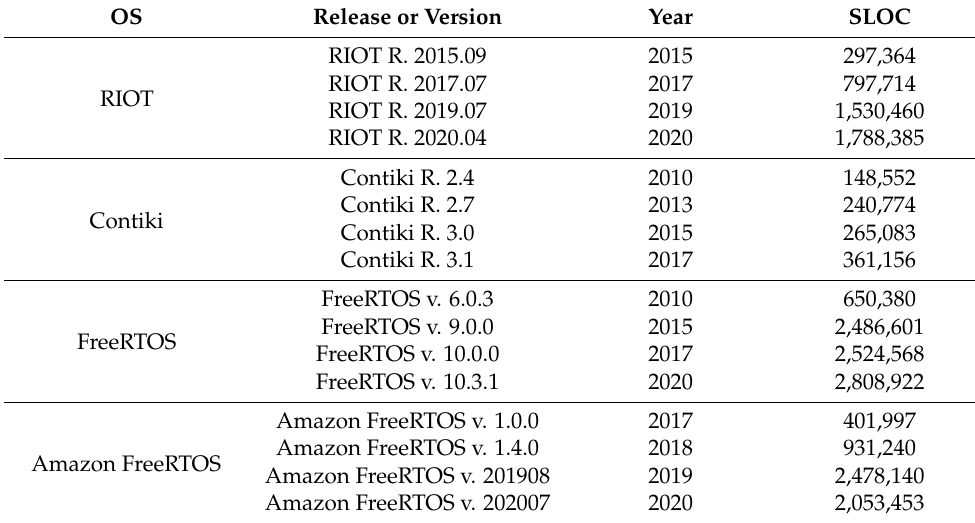
Table 3. Case study of IoT OSs